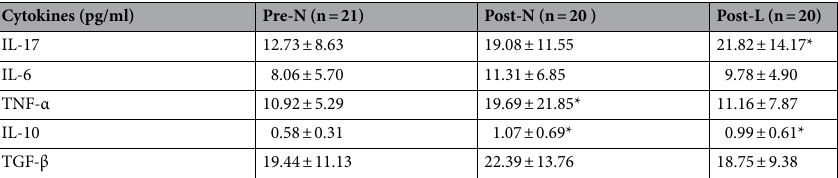
Table 2. Comparison of plasma level of cytokines between premenopausal and postmenopausal women with normal and low BMD. Values are expressed as Mean ± SD. * p < 0.05; when compared to Pre-N. Statistical significance was estimated using the Mann–Whitney U test. Abbreviations: Pre-N premenopausal women with normal BMD, Post-N postmenopausal women with normal BMD, Post-L postmenopausal women with low